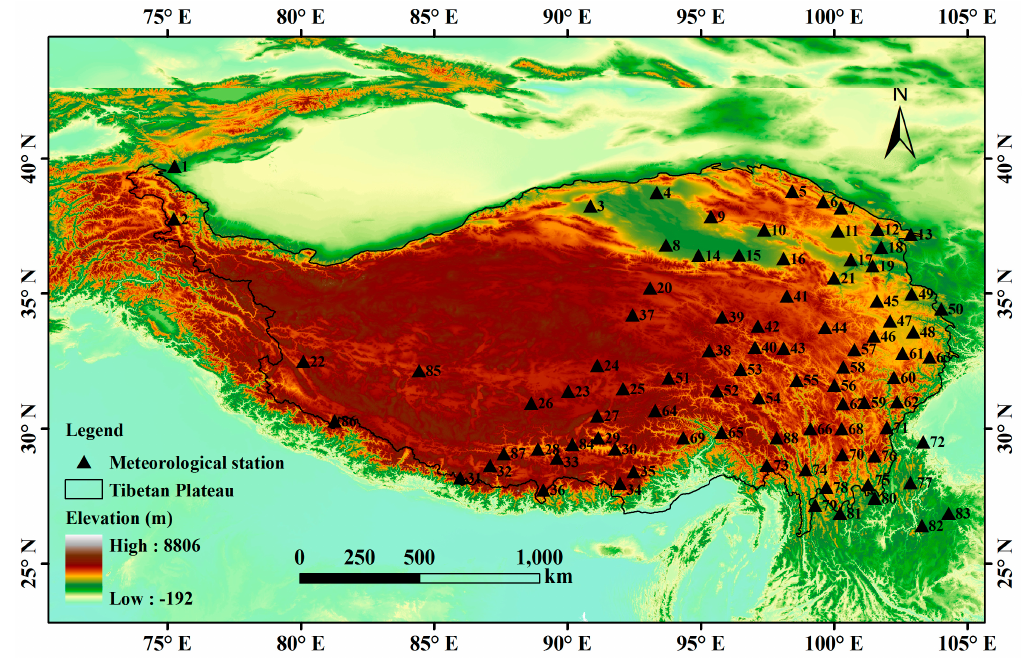
Figure 1. The locations of selected stations.